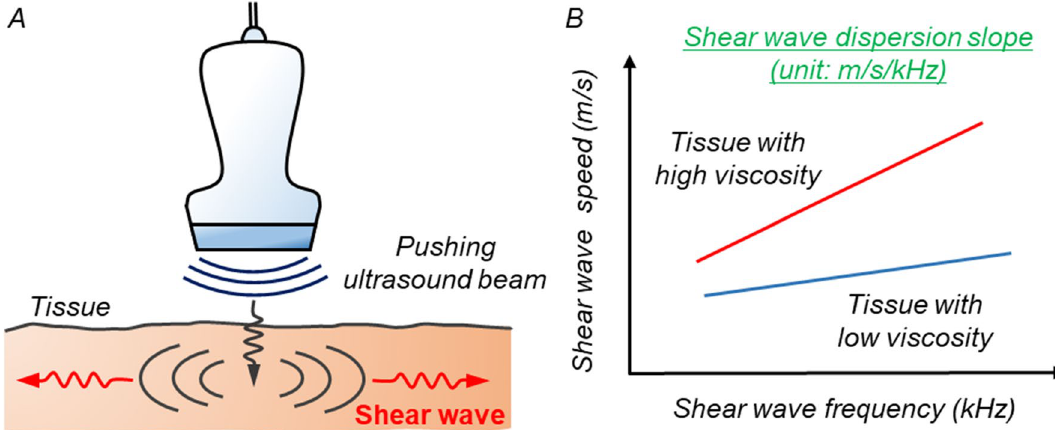
Figure 1. Mechanism of shear wave dispersion slope for assessing tissue viscosity. ( A ) Mechanism of shear wave generation in biological tissue. ( B ) Relationship between shear wave dispersion slope and tissue